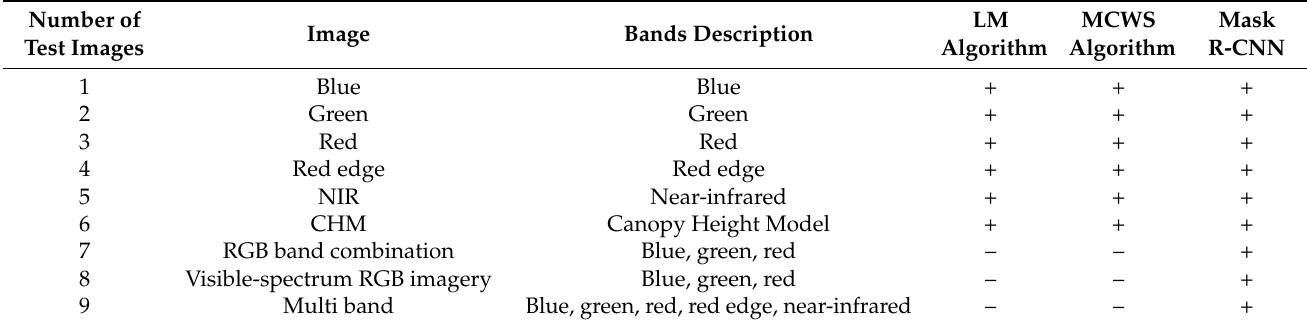
Table 1. The description of different images as the input